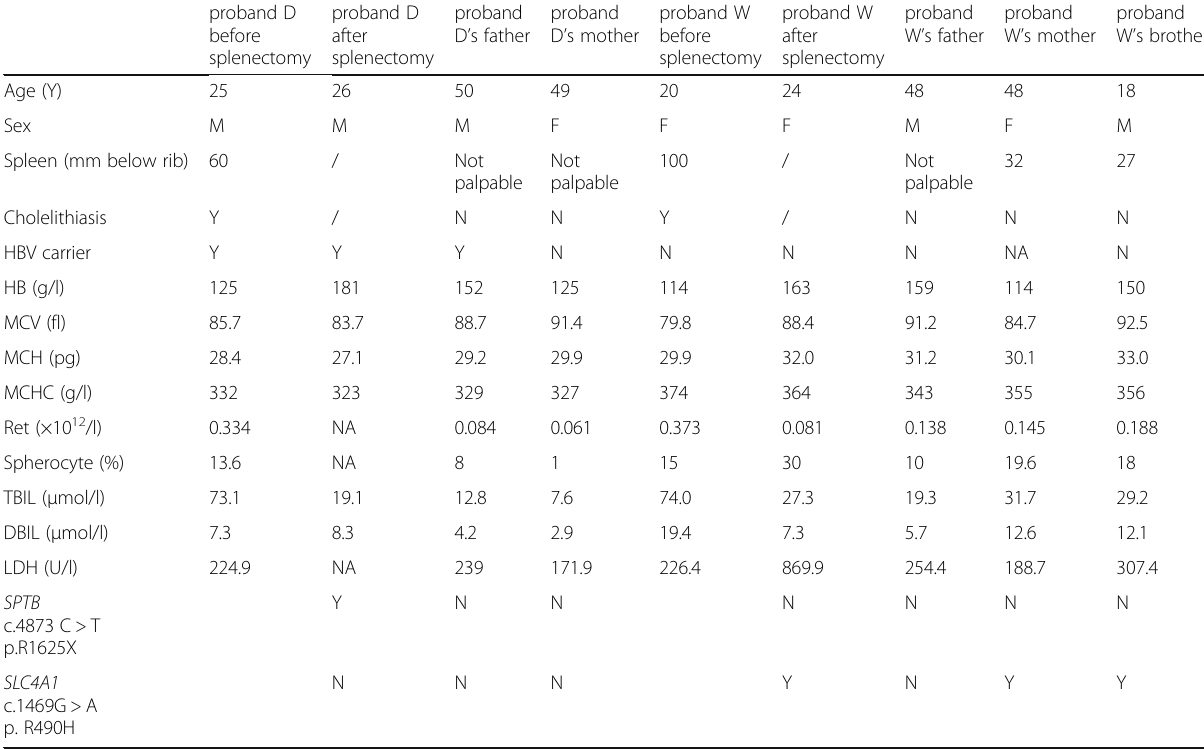
Table 1 Clinical and genetic features of proband D, proband W and their immediate family members